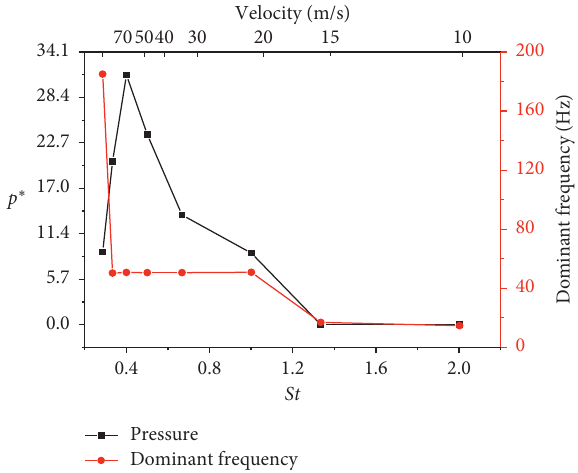
Figure 8: Dominant frequency (right) and pressure amplitude (left) as function of St (bottom) and velocity